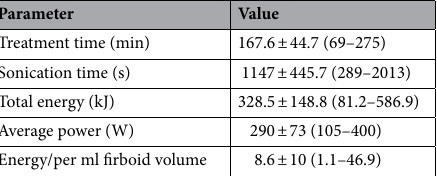
Table 2. Therapeutic parameters of US-guided HIFU treatment in patients with uterine fibroids (n = 40).